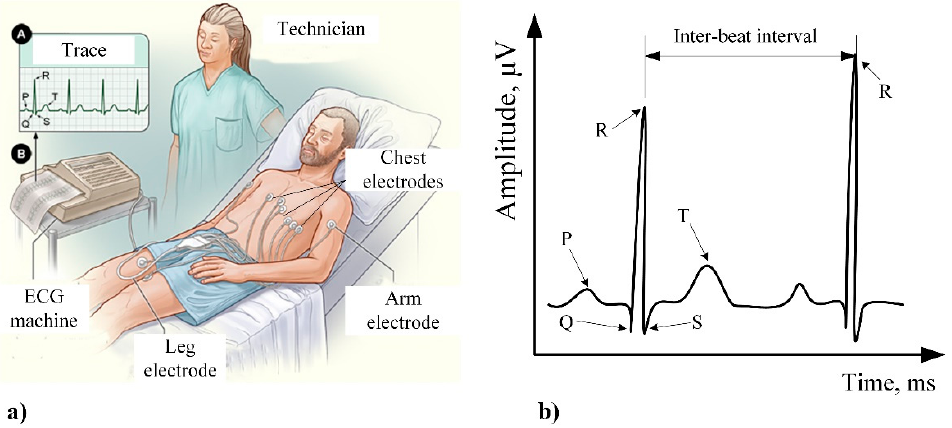
Figure 5. ECG procedure [72]: ( a ) typical set up; ( b ) Main parameters of an ECG heartbeat signal.